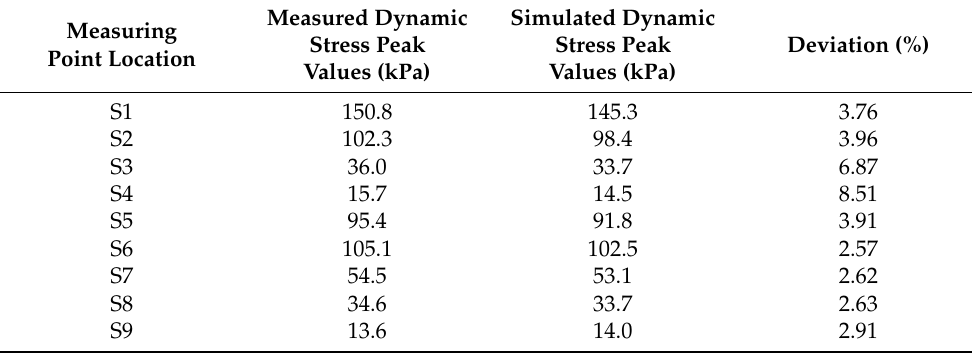
Table 4. Peak values of vertical dynamic stress at different positions.